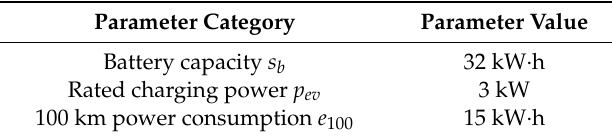
Table 2. Electric vehicle performance parameters.